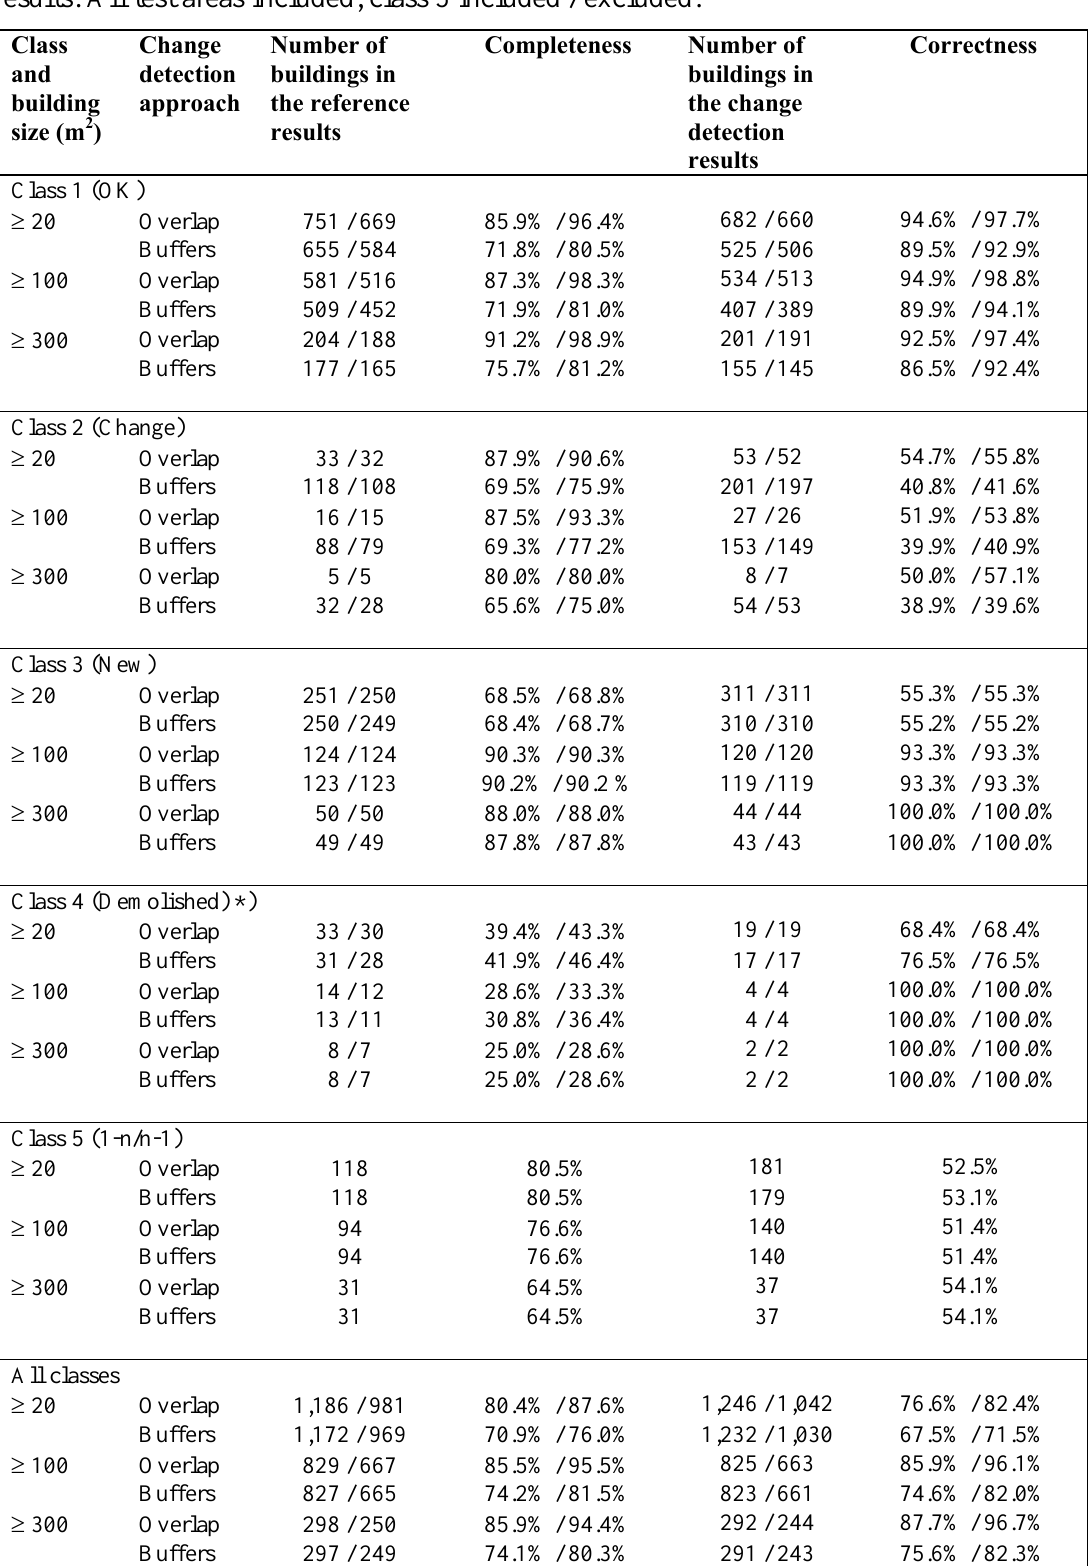
Table 5. Building-based accuracy estimates for different classes in the change detection results. All test areas included, class 5 included /